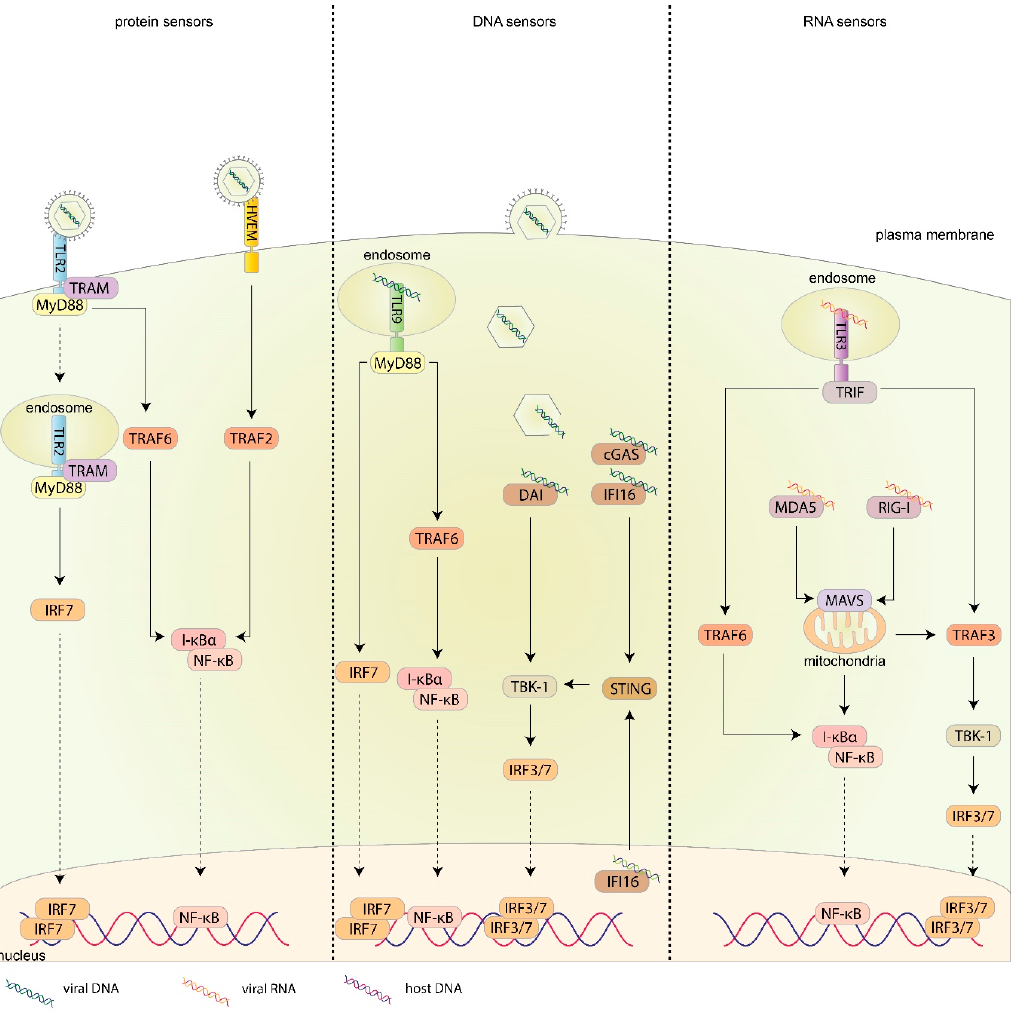
Figure 1. Recognition of HSV-1 by the innate immune system. HSV-1 is recognized by PRRs (pattern recognition receptors) to activate a signaling cascade leading to interferon (IFN) and cytokine production. Viral protein sensors include toll-like receptor (TLR) 2 and herpes virus entry mediator (HVEM). Viral DNA sensors include TLR9, cyclic guanosine monophosphate-adenosine monophosphate synthase (cGAS), IFN inducible protein 16 (IFI16) and DNA-dependent activator of IFN-regulatory factors (DAI). Viral RNA sensors include TLR3, melanoma differentiation-associated protein 5 (MDA5) and retinoic acid-inducible gene I (RIG-I). Solid lines represent downstream activation, dashed lines represent translocation.